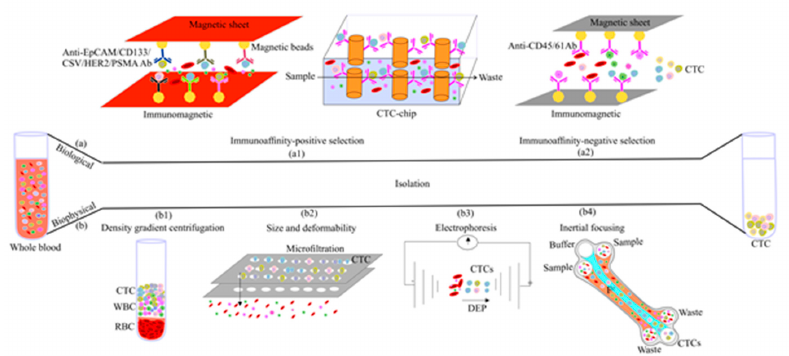
Figure 4. Methods for CTC enrichment based on their ( a ) biological, and ( b ) biophysical properties. Immunoaffinity-based CTC isolation using two strategies: ( a1 ) Positive enrichment where CTCs or CTSCs are captured by immunomagnetic devices or CTC-chips by trapping their surface markers, such as EpCAM, CD133, HER2, CSV, prostate-specific membrane antigen (PSMA); and ( a2 ) Negative enrichment by depletion of WBCs and platelets using anti-CD45 and -CD61 antibodies, respectively. ( b1 ) Density: CTC density is lower than that of red blood cells and white blood cells; ( b2 ) Size and deformability: filters with pores of 7- 8 μ m in diameter allow the passage of blood components, but not of CTCs; ( b3 ) The distinct electrical charges of CTCs and blood cells allow separating these cell types; and ( b4 ) Inertial focusing: CTCs are passively separated using microfluidic devices based on their size through the application of inertial forces (shear-gradient lift force and a wall effect lift force) that affect cell positioning within the flow channel.